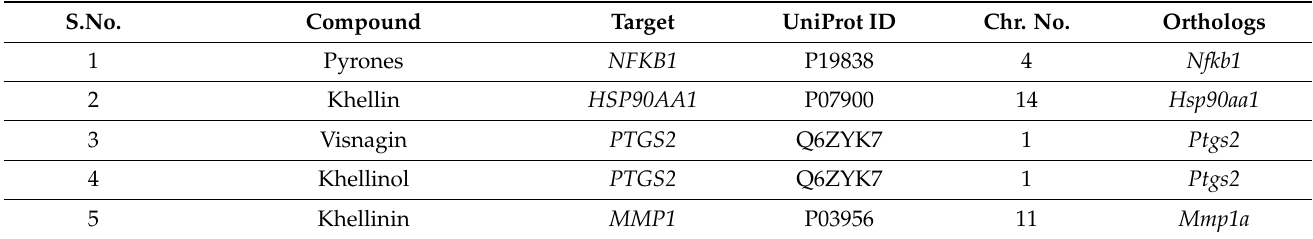
Table 2. Features of compound-targeted potential